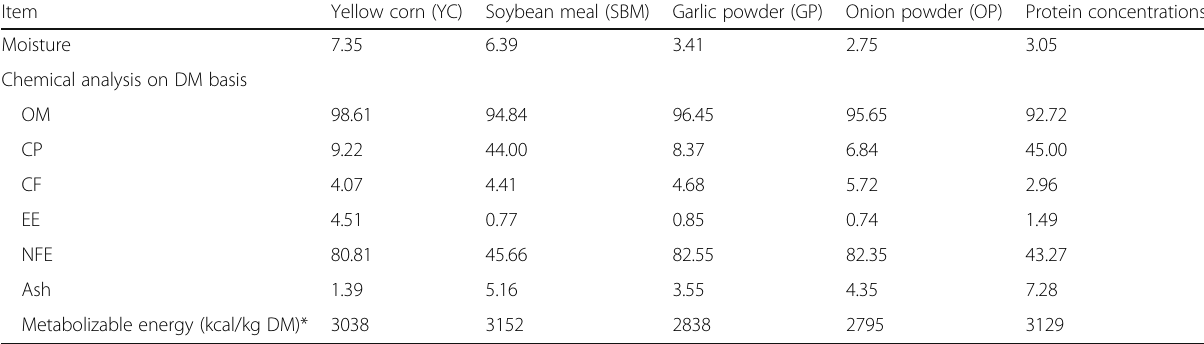
Table 2 Chemical analysis (%) of feed